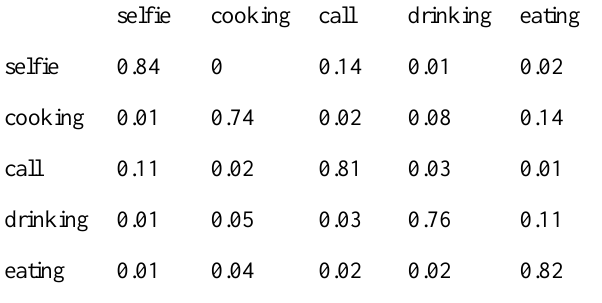
Figure 8. Confusion matrix on MSCOCO